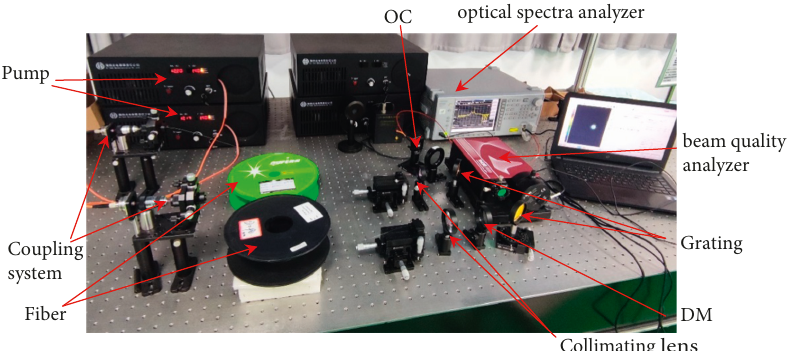
Figure 7: Experimental setup for producing tunable